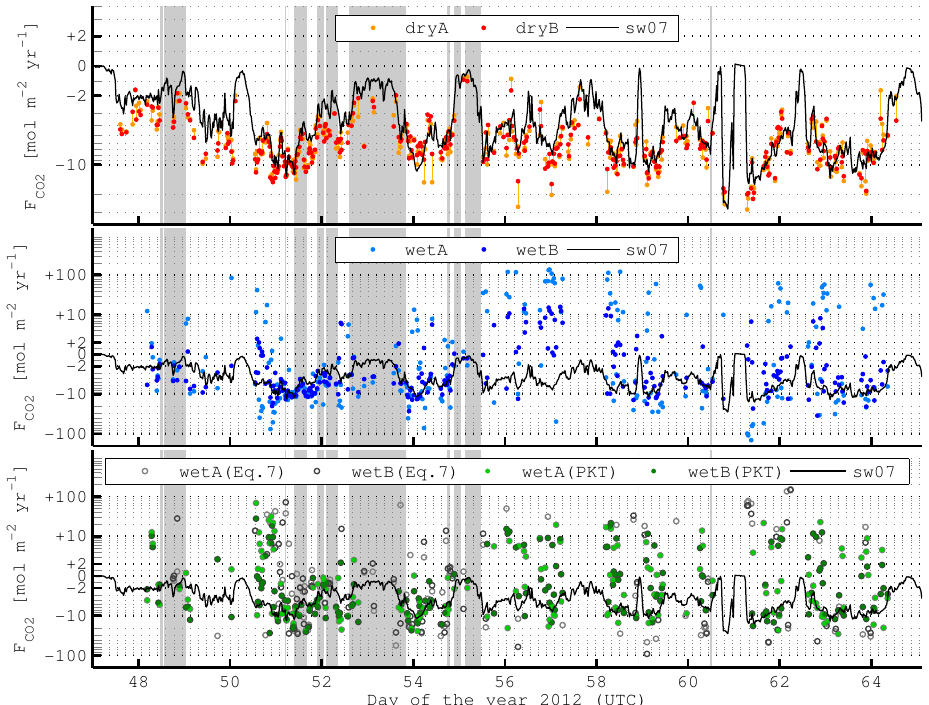
Fig. 3. Time series of the direct CO 2 fluxes and the flux calculated with the parameterisation of Sweeney et al. (2007), plotted on logarithmic scale with sign. Values in the range of 2molm − 2 yr − 1 are plotted on linear scale. Shaded areas mark low latent heat fluxes (Hl ≤ 7Wm − 2 ). Top: fluxes from dryA and dryB parallel measurements are linked with vertical lines; middle: fluxes from wetA and wetB ; bottom: fluxes from wetA and wetB after the PKT correction has been applied to the CO 2 measurements and the results from Eq. (7), which are overlaid with the PKT